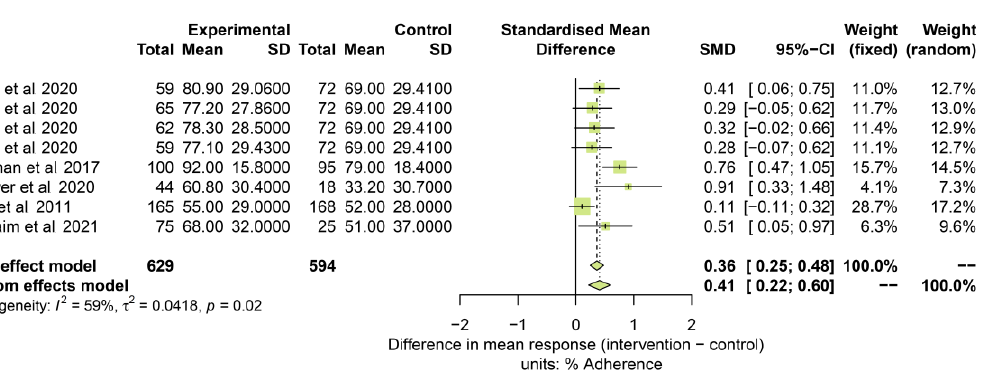
Figure 6. Adherence outcomes in studies 3 months or longer. References: 27, 51-53, 58.